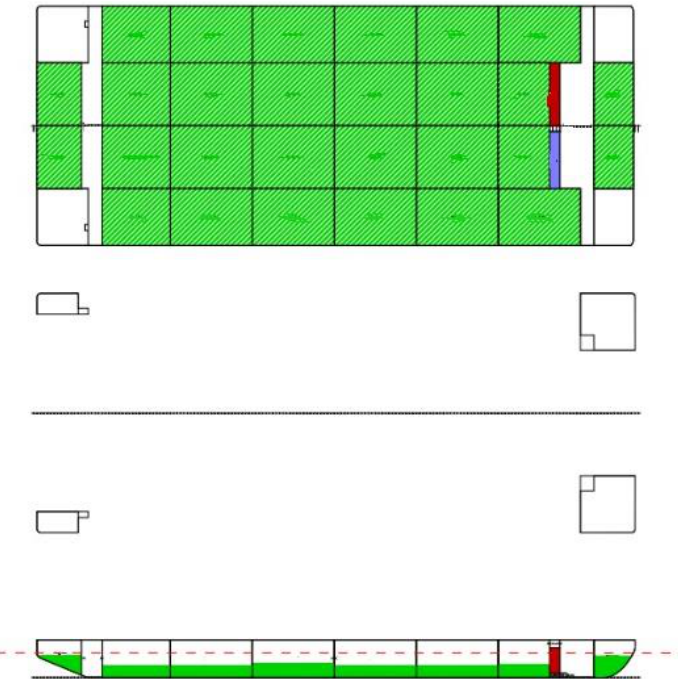
Figure 17. Schematic diagram of LCS2 ballast water distribution.